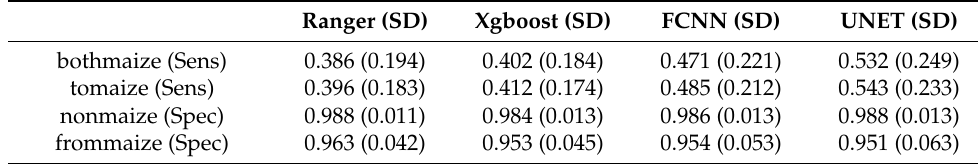
Figure 10. The figure shows a boxplot for the performance difference between scopes colored by model. Table 8. Overview of Spatiotemporal Generalization Scopes.